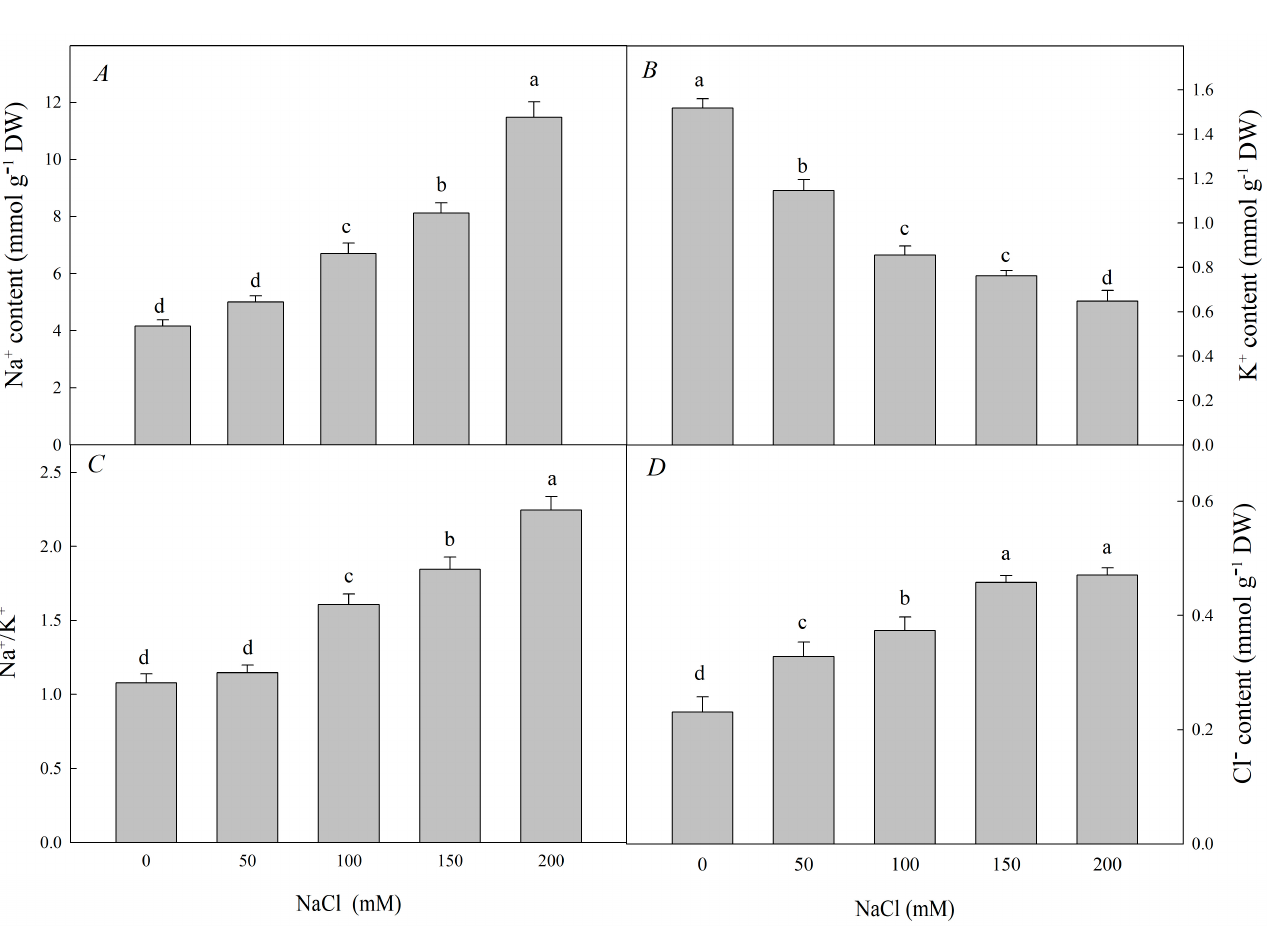
Figure 2. Effect of NaCl stress on Na + , K + , Cl − , and Na + /K + ratio and of R. pseudoacacia seedlings. ( A ) Na + content; ( B ) K + content; ( C ) Na + /K + ; ( D ) Cl − content. Values are mean ± SD of five biological replicates. Bars with different letters are significantly different at p < 0.05 according to Duncan’s multiple range tests.